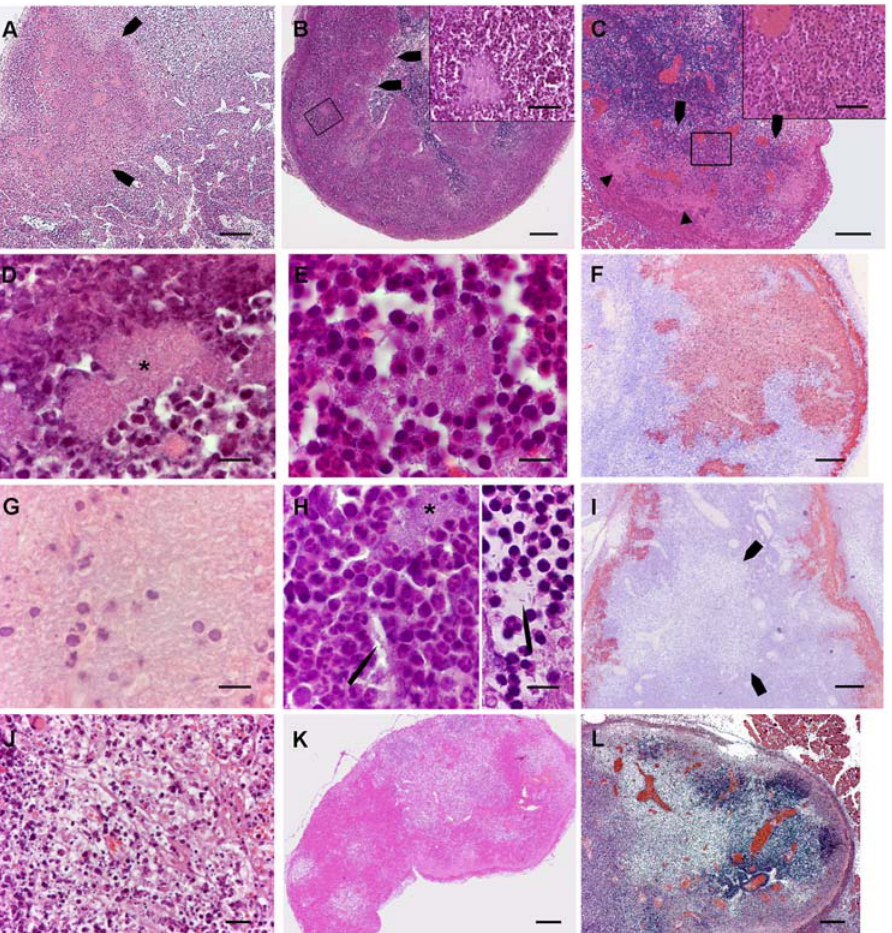
Figure 4. Illustrations of some of the criteria used for scoring. Panels A–E, G, H and J–L display HE stained sections, panels F and I show sections immunostained with Y. pestis specific antibodies. In the text below, the criteria are referred to according to the numbering in Table 1. A: Wedge shaped abscess (criterion 4) indicated by arrows. Within the abscess bacterial colonies are visible as pink patches. B: Peripheral layer of PMNs containing bacterial foci (criterion 9), with a blunt demarcation (arrows) from the lymph node tissue (criterion 11). Inset: higher magnification to show the characteristic horseshoe shaped nuclei of the PMNs, and a bacterial focus. C: Layer of PMNs bordering a peripheral band of bacteria, cell debris and PMNs (criterion 10). The inset shows the typical PMN morphology of the cells within the layer. Behind this layer, bacterial aggregates are seen as pink areas (arrowheads) containing purple dots that are, as seen as higher magnification (not shown here) PMNs and cell debris. D: Patch of densely packed bacteria, bordered by PMNs (criterion14). Packed bacteria form a pink 8-shaped area at the centre of the picture (star). E: Atypical bacterial patch (criterion 15). At the center of the picture an aggregate of bacterial rods, not as densely packed as the preceding one, is loosely surrounded by inflammatory cells. F: A large bacterial zone (criterion 17), stained brownish on the preparation. G: Isolated host cells within a bacterial zone (criterion 19). Isolated host cells and cell remnants are seen amid a sea of bacteria which gives a ‘‘ground glass’’ appearance to this part of the LN section. H, left : bacterial infiltration around host cells (criterion 20). A bacterial strand (arrow), that seems to originate from a nearby colony (star), passes between host cells. H, right : Free floating bacterium, indicated by an arrow (criterion 21). I: Zone of reduced tissular density (arrows) outside bacterial areas, which are brownish on this preparation (criterion 26). This image also shows flame-like inward bacterial projections (criterion 18). J: Area of reduced host cell density with a reticular pattern (criterion 27) and containing numerous pycnotic cells (criterion 32). K: Moth eaten appearance (criterion 33) of a lymph node with areas of contrasting tissular densities. L: Vascular congestion (criterion 40), showing bright red on this preparation. Magnifications : Panels A–C, F, I–L : bar=200 m m. Insets of panels B and C: bar=50 m m. Panels D, E, G and H: bar=10 m m.